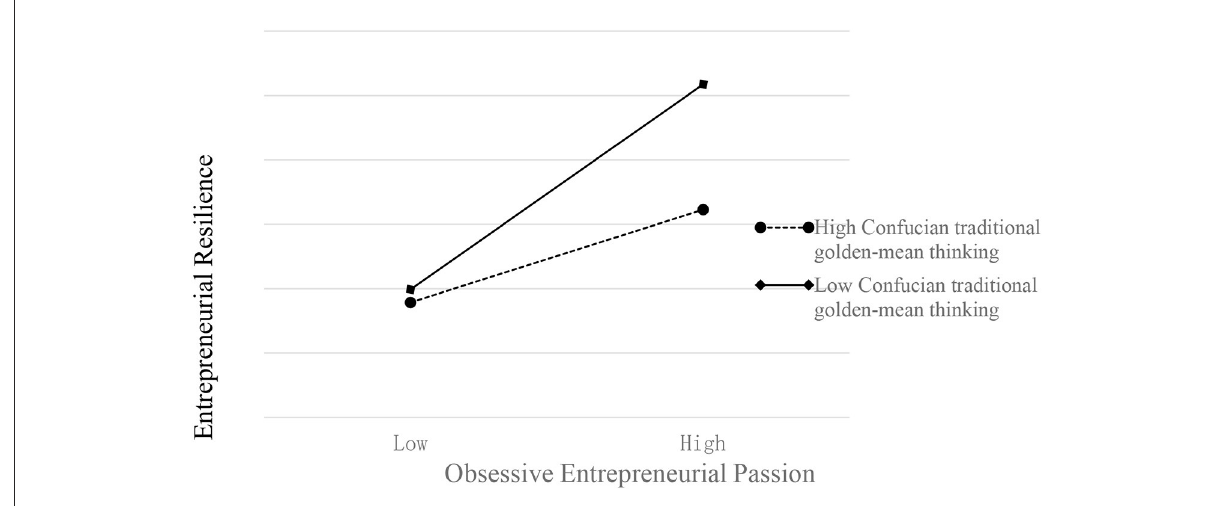
FIGURE3 Cross-level moderating effects of Confucian traditional golden-mean